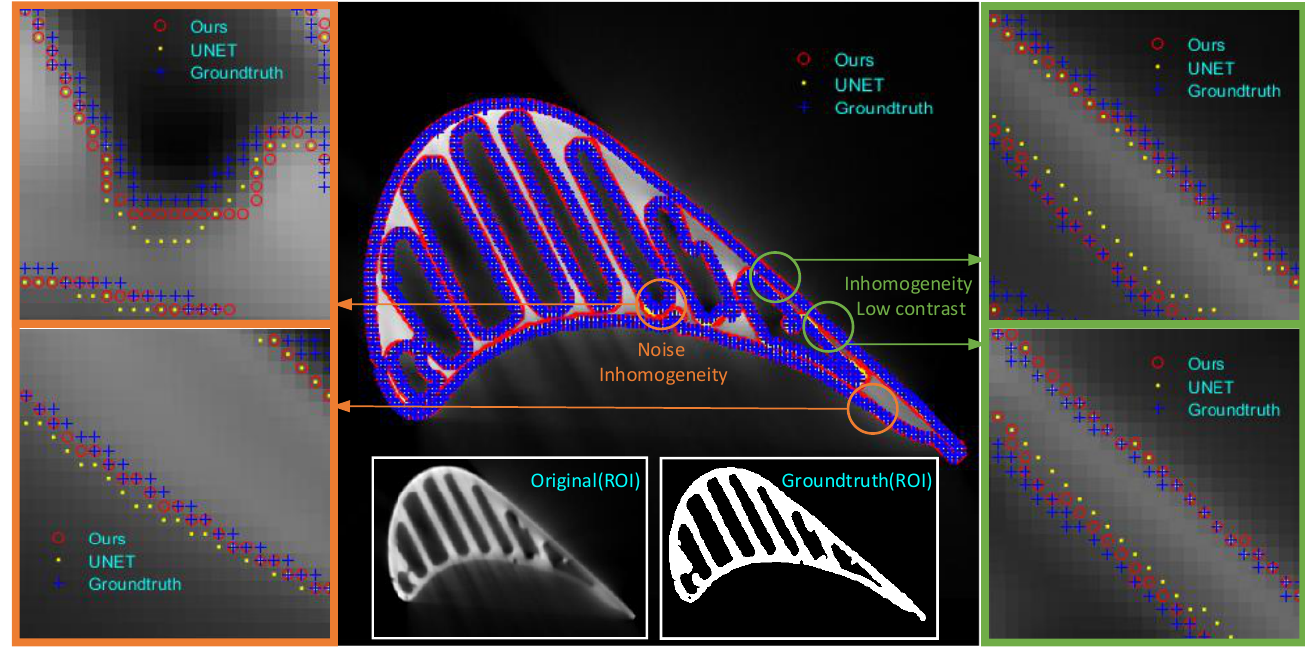
Figure 7. Robustness analysis of the proposed approach on the low-quality sample 1#268.